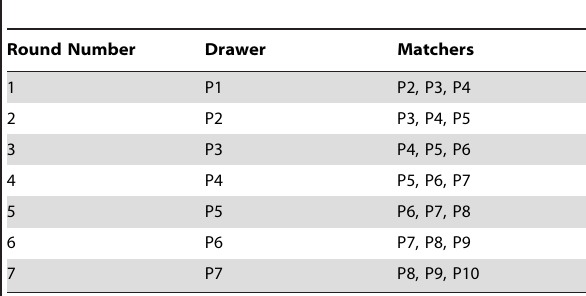
Table 1. Composition of the test group over rounds of the experiment (participant numbers indicated by